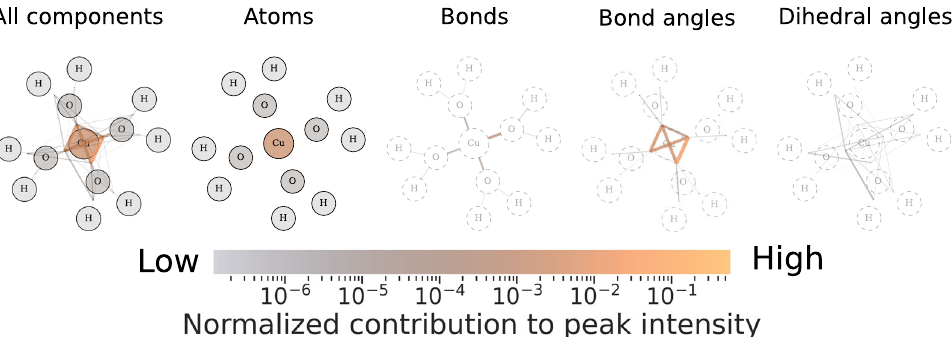
Fig. 6 Graph visualization of the relative contributions of atomic, bond, bond angle, and dihedral angle components to spectral peak intensity for one fourfold-coordinated Cu(II) aqua con fi guration. The largest contributions are derived from O-Cu-O bond angles and the central copper, followed by Cu-O bonds and certain dihedral angles. Color and line thickness indicate the magnitude of the relative contributions. For the visualizations of the bond and angle components, the atoms are faintly outlined.